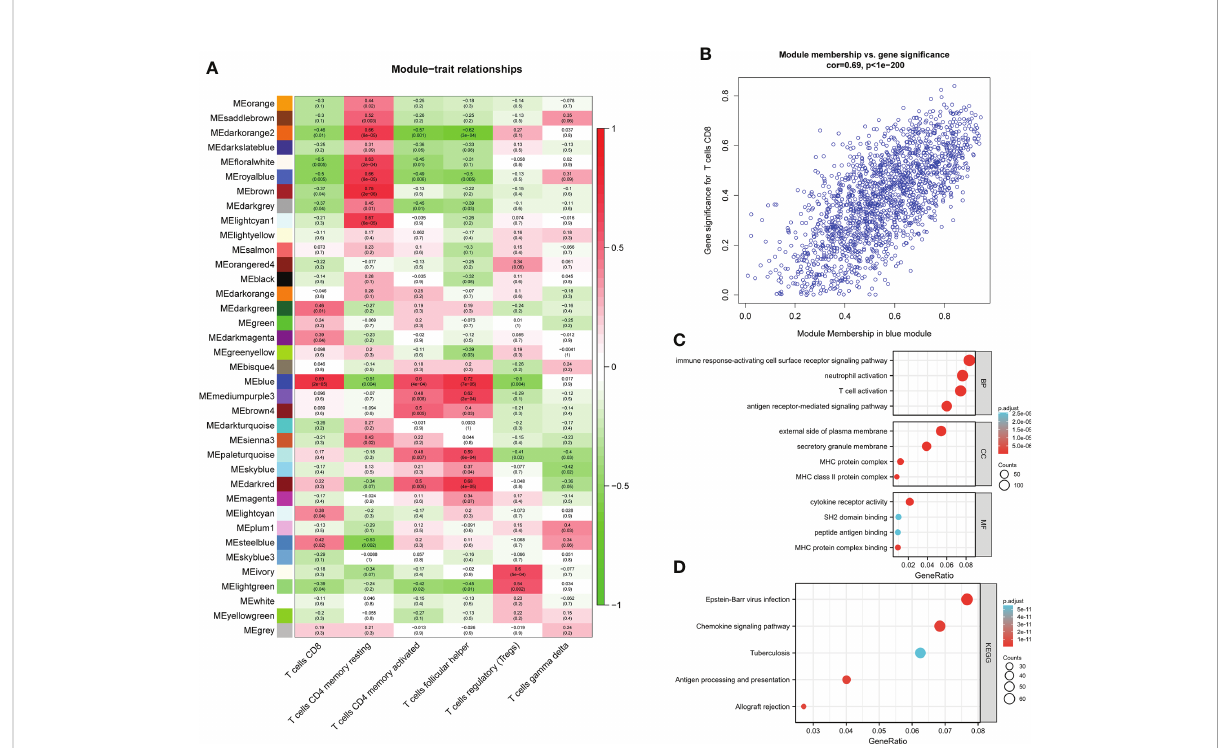
FIGURE 2 module – trait correlations and Functional enrichment analysis (A) Heat map of module – trait correlations. Red represents positive correlations and blue represents negative correlations. (B) Module Membership in the blue module. (C) GO analysis. (D) KEGG analysis.